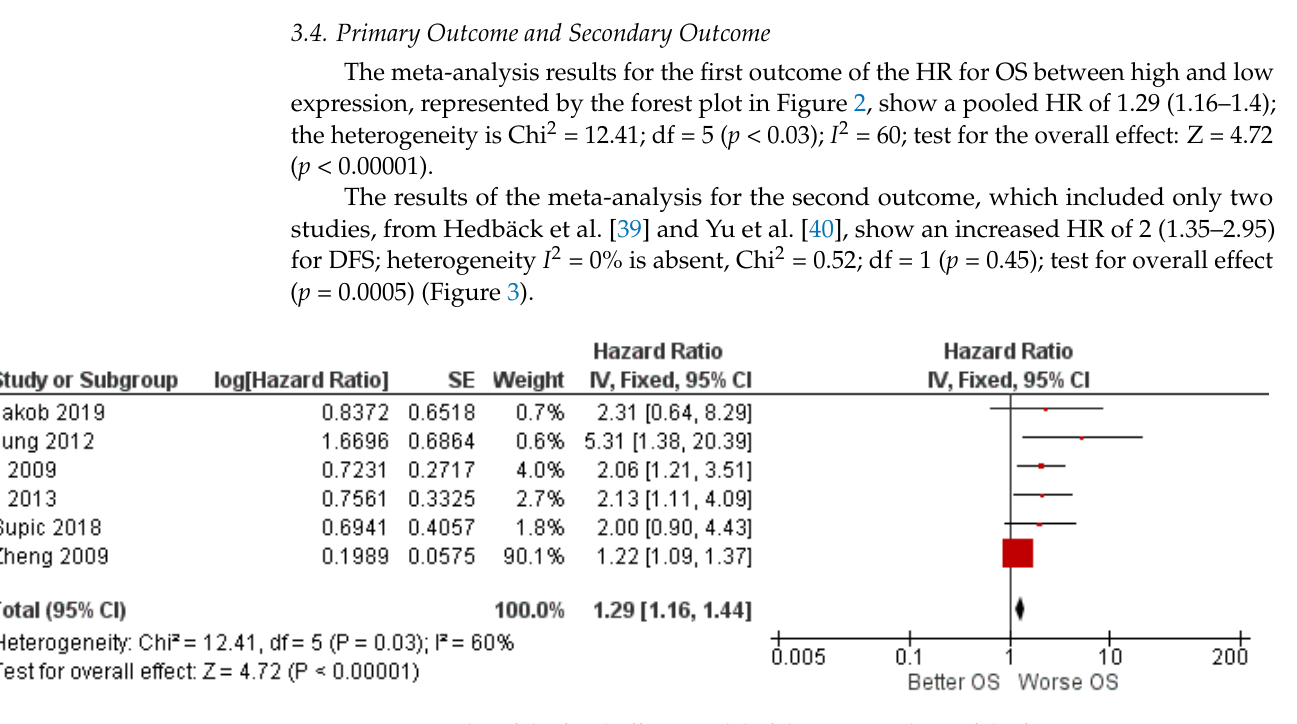
Figure 2. Forest plot of the fixed-effects model of the meta-analysis of the first outcome.